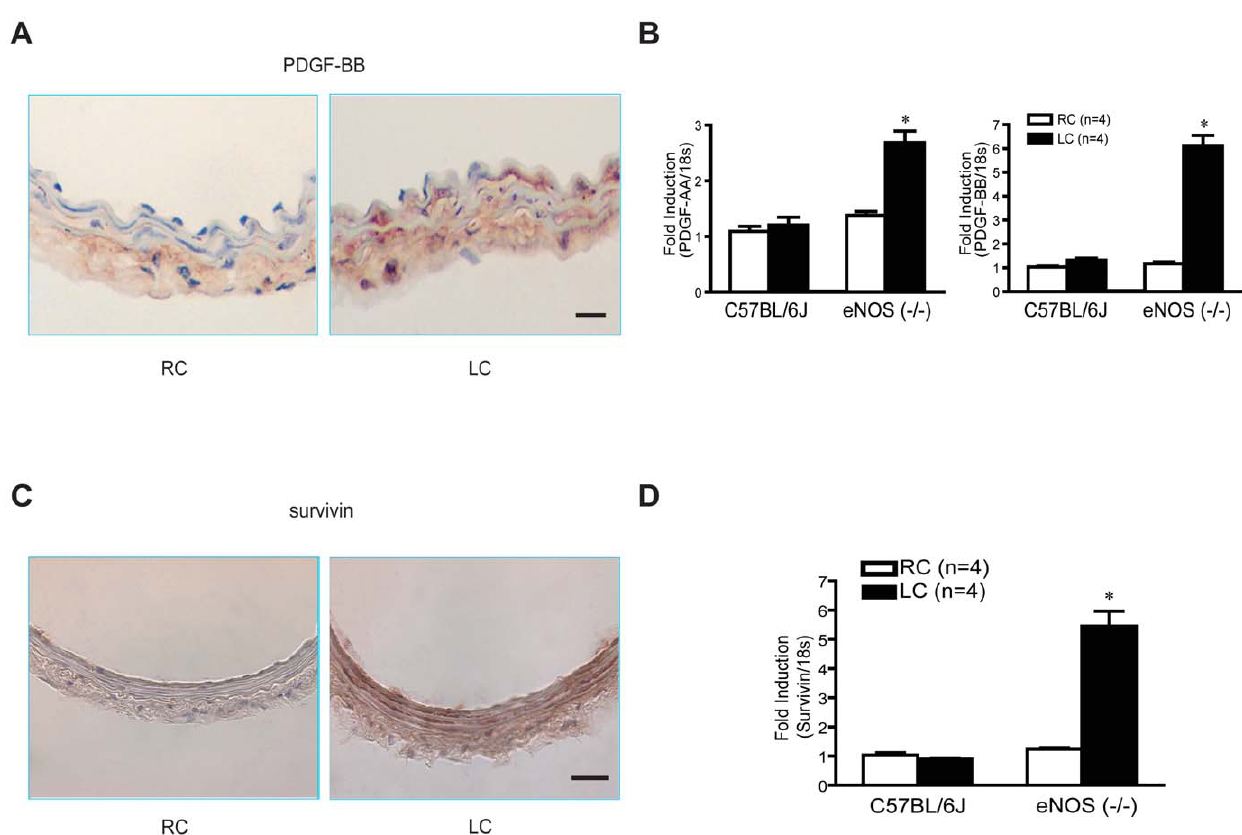
Figure 2. PDGF-AA, PDGF-BB and survivin levels are increased in eNOS ( 2 / 2 ) mice in response to remodeling stimulus. (A), Immunohistochemistry of PDGF-BB protein shows that it is present in adventitia of RC but is increased in all layers of LC post-ligation. Scale bar, 10 m m. (B), Quantitative RT-PCR of PDGF-AA and BB shows there was no change of PDGF mRNA level in wild type mice after LEC ligation. However, PDGF-AA and BB mRNA are all elevated in ligated LC compare to contralateral RC in eNOS ( 2 / 2 ) mice, 18 s was used as internal control. (C), Survivin immunohistochemistry shows strong staining throughout whole vessel wall of LC, and there is little or no staining in RC. Scale bar equals to 10 m m. (D), RT-PCR shows equal expression of survivin mRNA of contralateral RC and ligated LC in wild type mice. However, survivin was upregulated in ligated LC of eNOS ( 2 / 2 ) mice. 18 s was used as internal control.